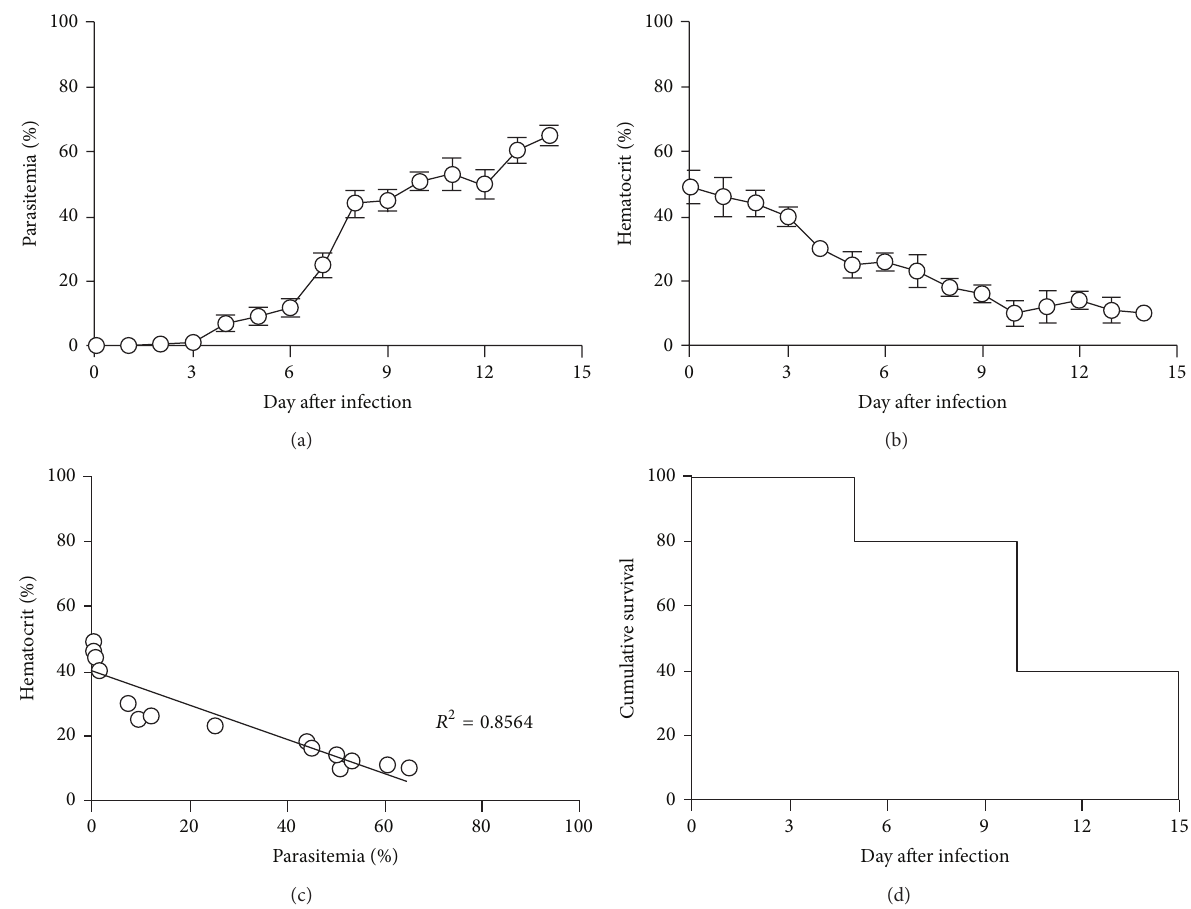
Figure 1: Malaria-associated hemolysis induced by Plasmodium berghei infection. ICR mice (5 mice of each) were inoculated by 6 × 10 6